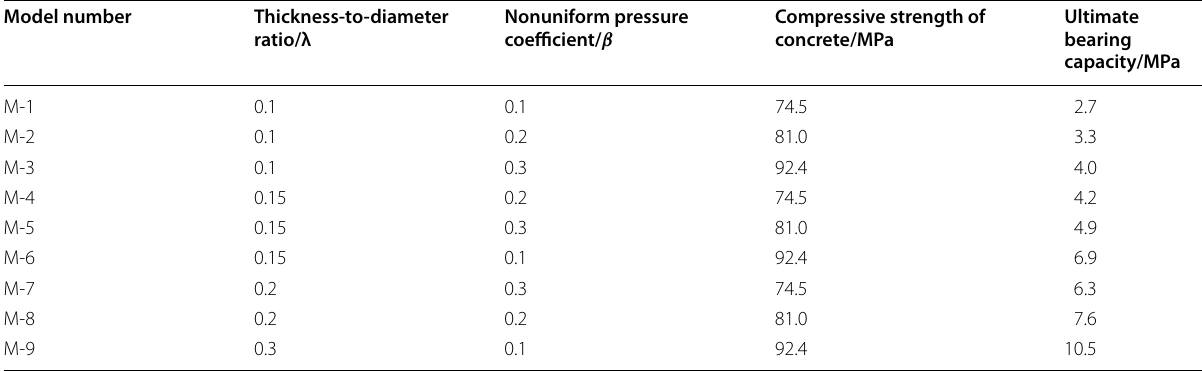
Table 7 Ultimate bearing capacity of shaft wall structure. Model number